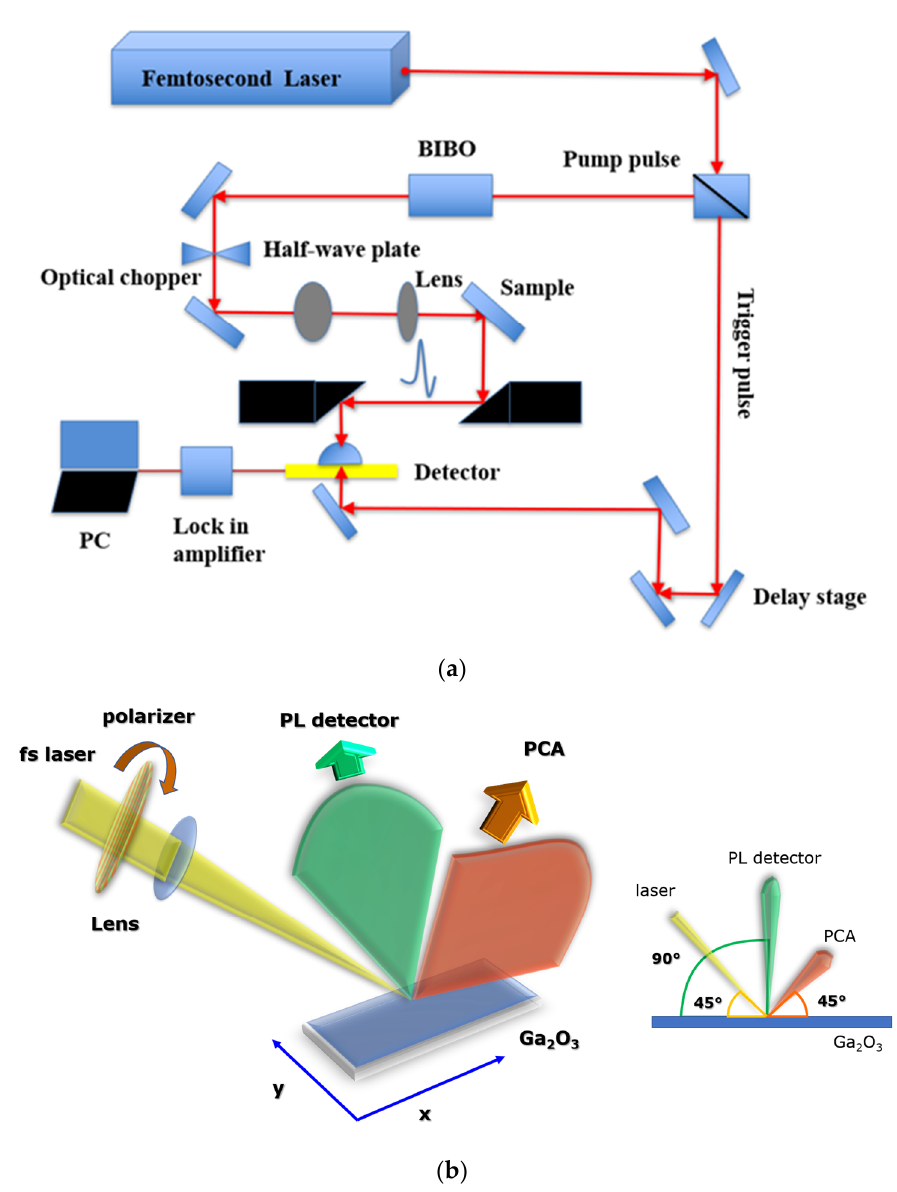
Figure 2. Schematic drawing of ( a ) the whole experimental setup and ( b ) the geometrical relationship among the incident laser beam, photoluminescence (PL) and terahertz (THz) detector positions.